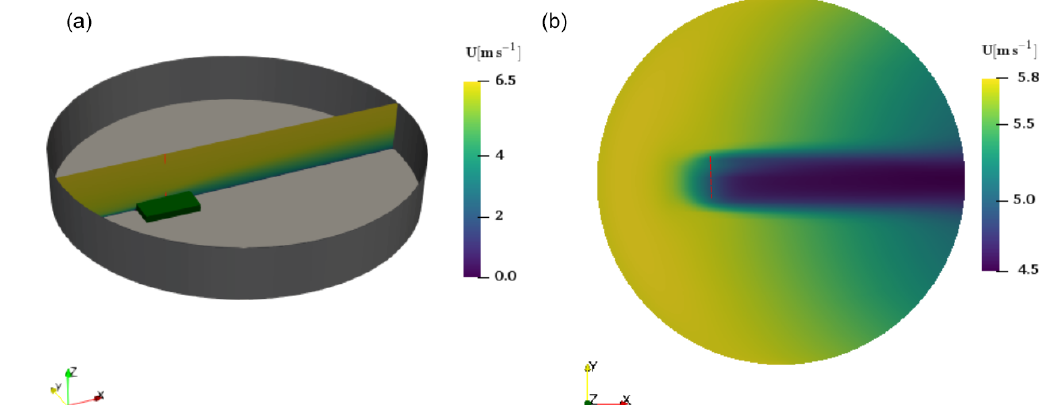
Figure 2. The CFD-simulated velocity obtained from the reference simulation (WD = 270 ◦ ): the general view of the domain including the cubic forest and the velocity field on a plane at the center of the domain, y = 0, (a) . The red line on the plane represents the location of desired target velocity profile (see Fig. 3). The velocity field on a plane at z = 45m above the ground (b) .